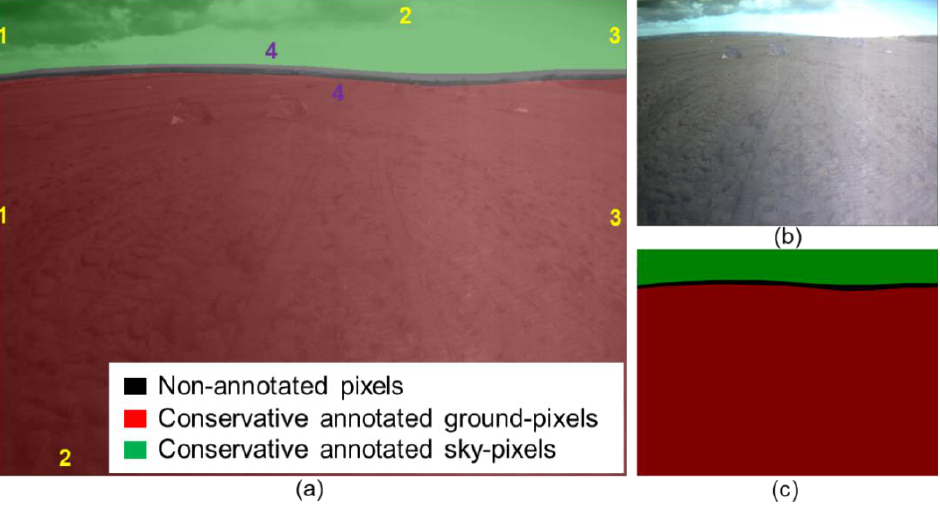
Figure 7. The proposed conservative labeling method. “1”, “2”, “3”, and “4” refer to the index of the boundaries. Gold “1”, “2”, and “3” refer to the easy-annotated boundaries, and purple “4” refers to the difficult-annotated boundaries. ( a ) adds the transparent conservative label to the original image. ( b ) refers to the original image. ( c ) refers to the conservative label.